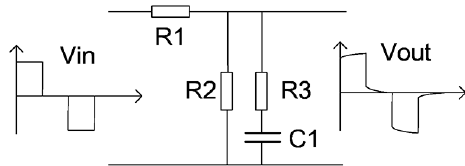
Figure 5. Schematic of the PZNZ waveform